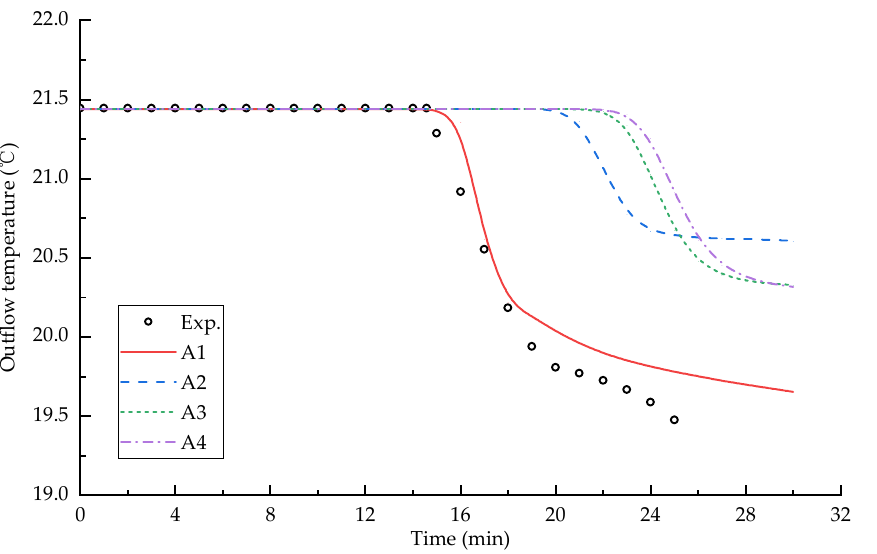
Figure 4. Time variation of outlet water temperature under different vertical coordinate models.